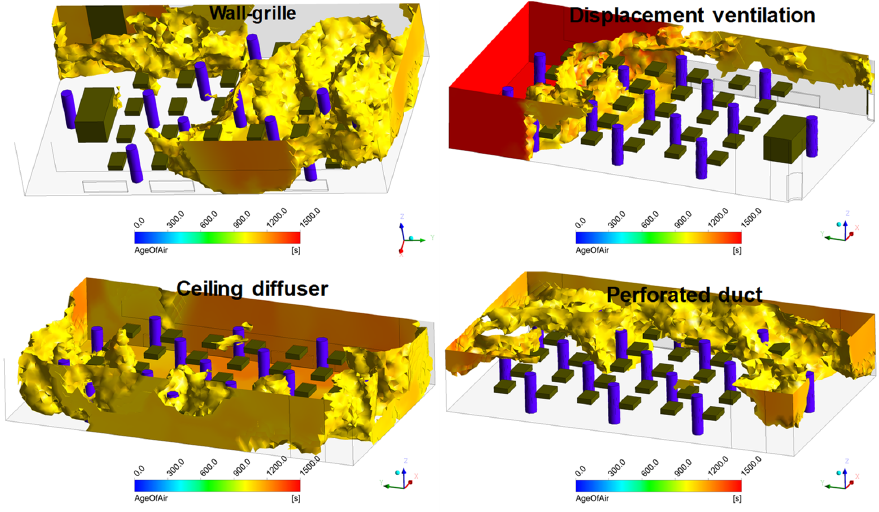
Figure 7. Iso-volume visualization of age distribution of air in the occupied zone over 1063 s (fully mixed condition) in the winter.